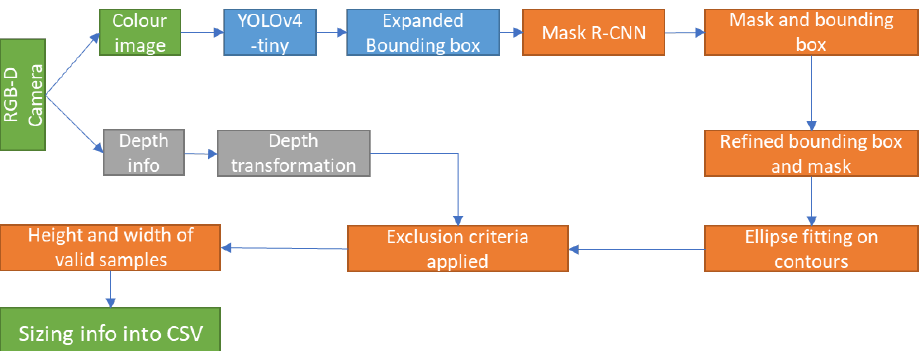
Figure 6. Method 2–Fruit sizing using Mask R-CNN instance segmentation on the entire image. Figure 6. Method 2 – Fruit sizing using Mask R-CNN instance segmentation on the entire image.